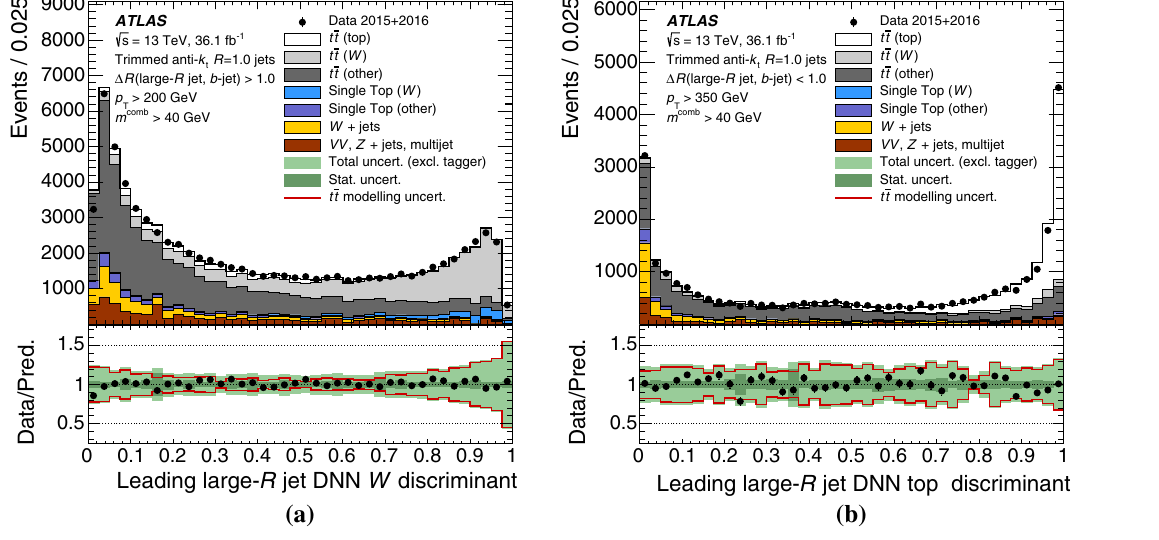
(e.g. t ¯ t (top)) based on criteria described in Sect. 4.2. The statistical uncertainty of the background prediction (Stat. uncert.) results from limited Monte Carlo statistics as well as the limited size of the data sample used in the data-driven estimation of the multijet